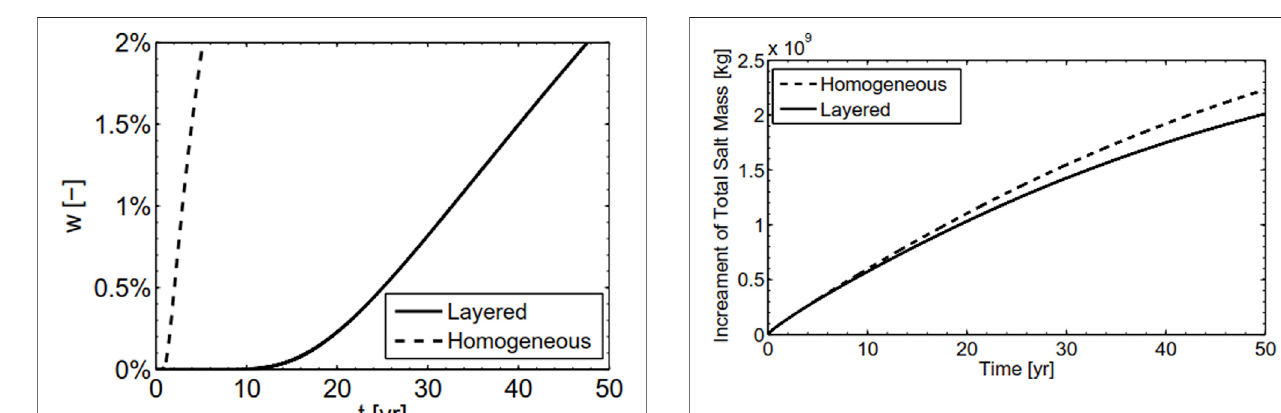
FIGURE 5 | The transient increment of the total mass within the model domain for the homogeneous (dashed line) and layered (solid line) cases. The layered case is the same case as in Figure 2